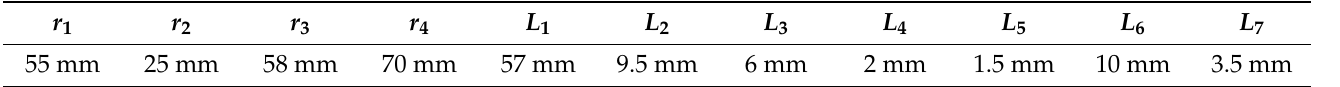
Table 1. Structural parameters of the transmission device.